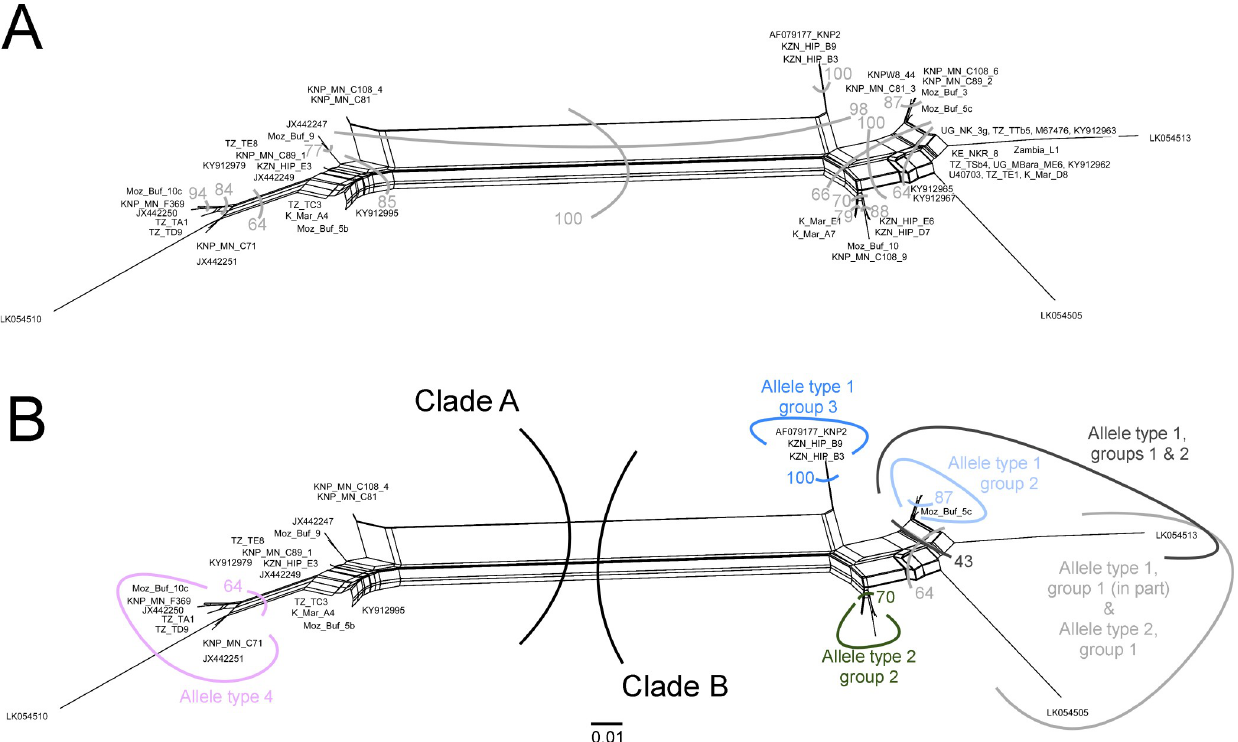
Fig 3. Data-display networks recovered from SplitsTree using all characters and uncorrected p-distances. Bootstrap support calculated from 1000 replicates. A : Indicates all major grouping with bootstrap support greater than 50. B : Allele types superimposed on network with accompanying support.